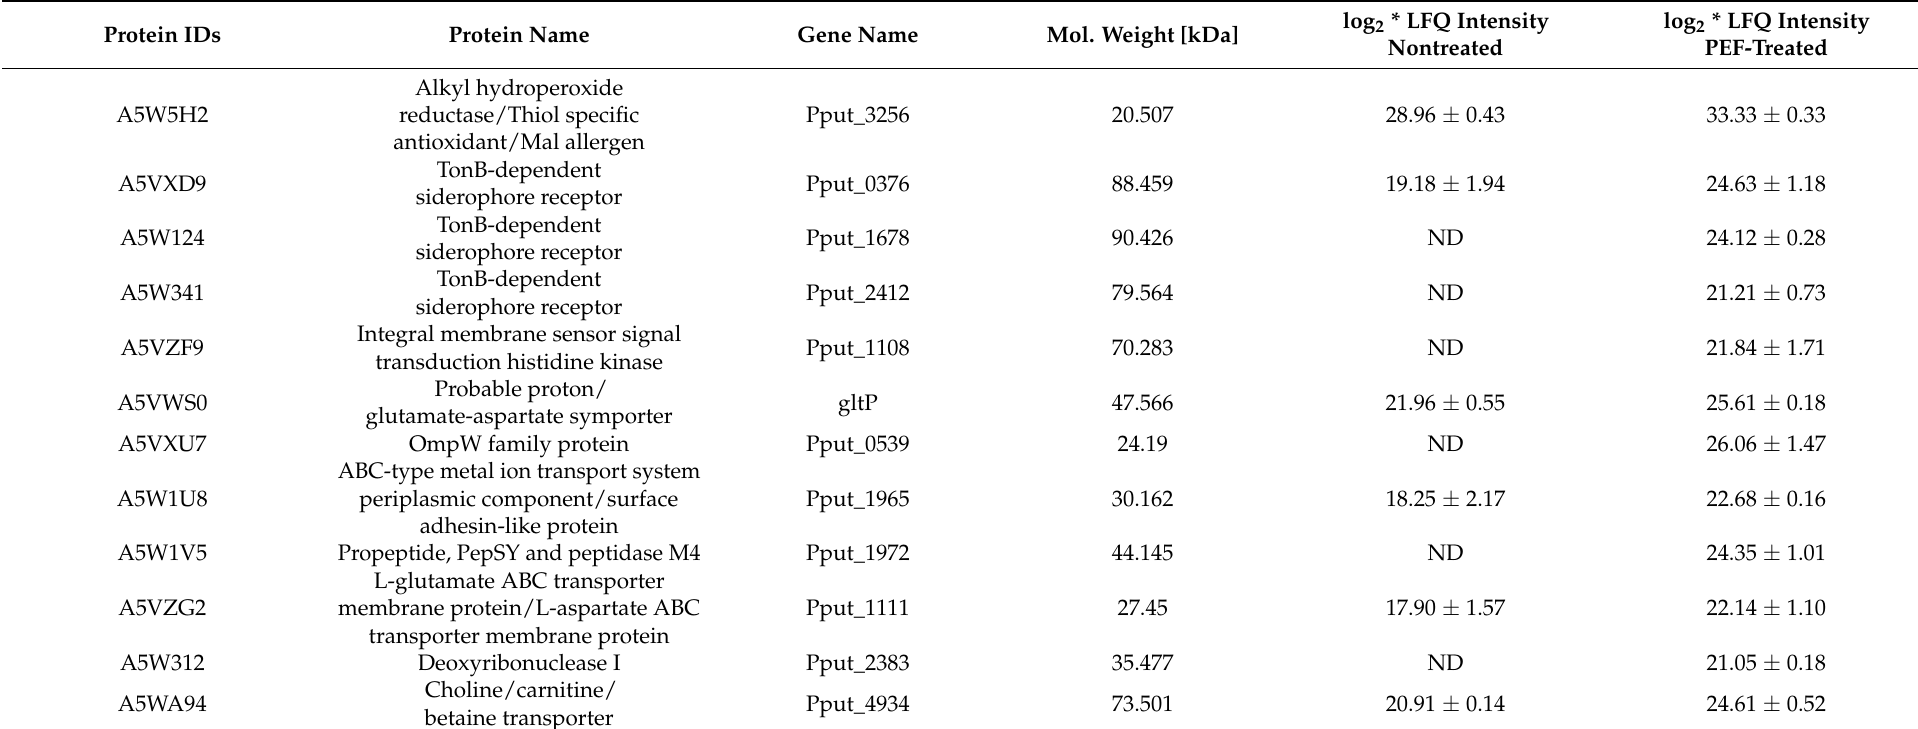
Table 1. MS (mass spectrometry) analysis of the over-expressed proteins from PEF-treated P. putida F1, compared to the nontreated